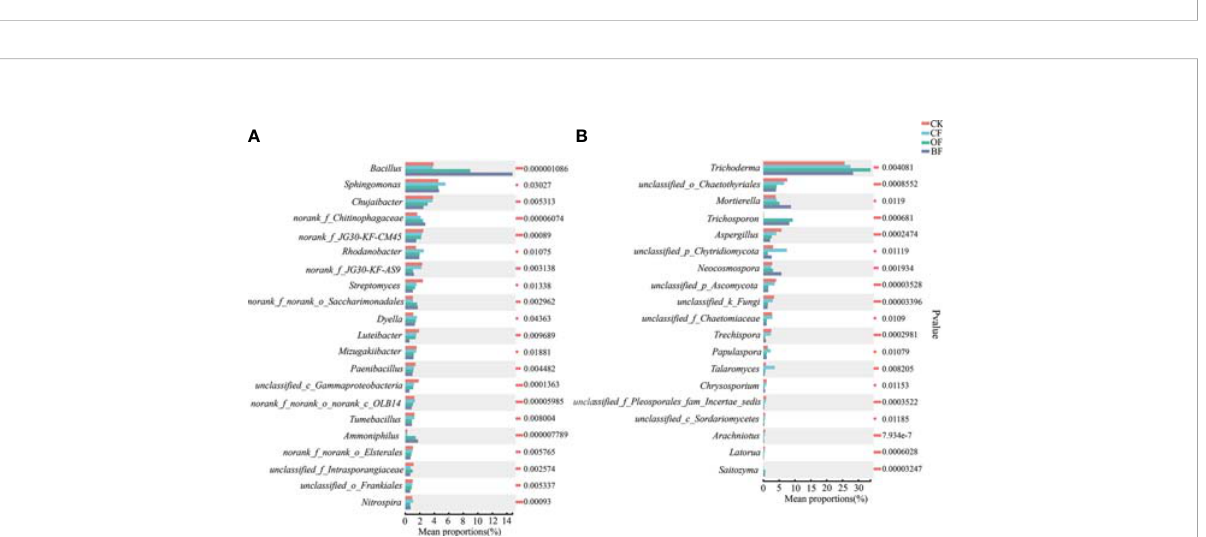
FIGURE 4 Differences in the composition of soil bacteria (A) and fungi (B) at the genus level in response to different fertilizer treatments. CK is untreated control; CF is chemical fertilizer; OF is organic fertilizer; BF is bioorganic fertilizer. The number of asterisks indicates signi fi cant differences between treatments according to a one-way ANOVA and FDR (False Discovery Rate) adjustment: * 0.01 < P ≤ 0.05; ** 0.001 < P ≤ 0.01; *** P ≤